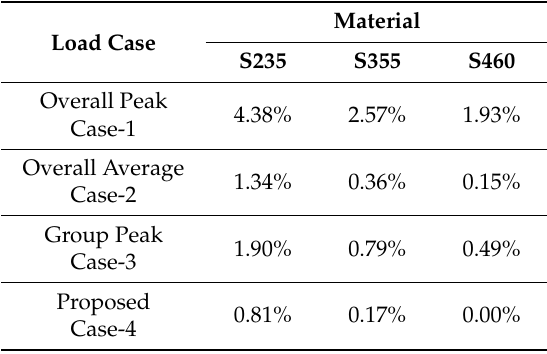
Table 11. Maximum strain for each load case and